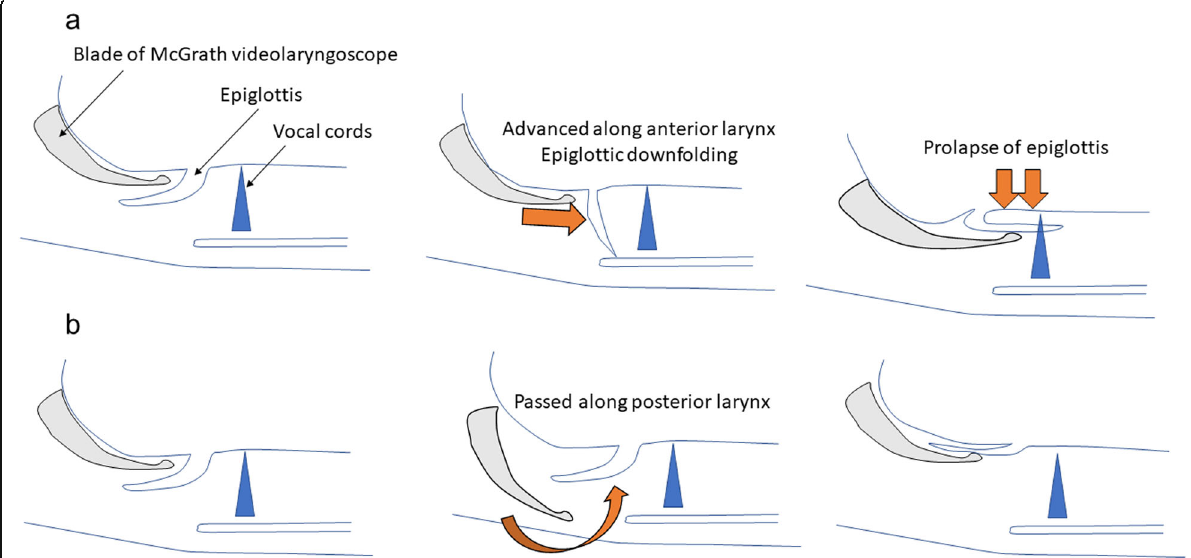
Fig. 2 Diagram showing the mechanism of epiglottic downfolding and how this complication can be avoided. a When the blade of the McGrath videolaryngoscope is passed along the anterior larynx to directly elevate the epiglottis, epiglottic prolapse can occur. However, this could be difficult to be detected because the epiglottis is not visible on the screen of the McGrath videolaryngoscope. b If it is necessary to elevate the epiglottis directly, the epiglottis should be lifted from the dorsal side to prevent